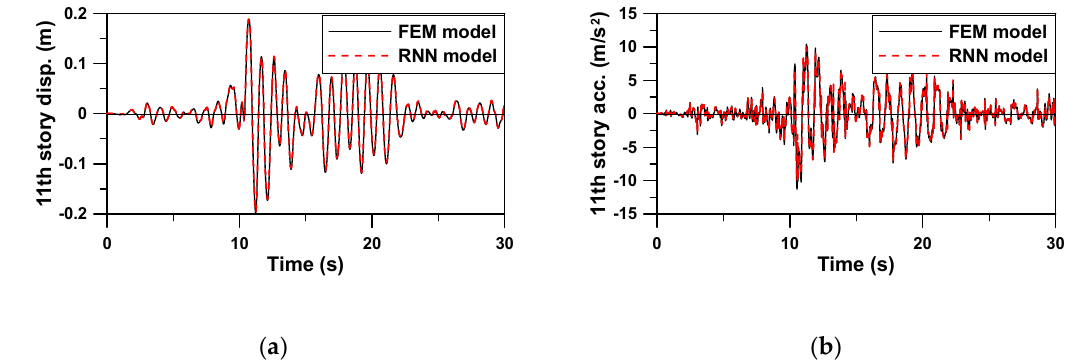
Figure10. ComparisonoftimehistoryresponsesofExample1betweenFEMandRNNmodels(EQ No. 13): Figure 10. Comparison of time history responses of Example 1 between FEM and RNN models (EQ ( a ) Displacement time history; ( b ) Acceleration time history. No. 13): ( a ) Displacement time history; ( b ) Acceleration time history.